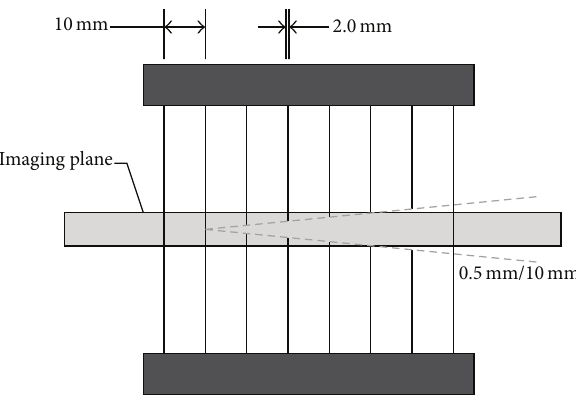
Figure 5: Slice thickness phantom. Dual inverted comb gradients locate the upper and lower edge of the imaging plane to determine actual slice thickness.